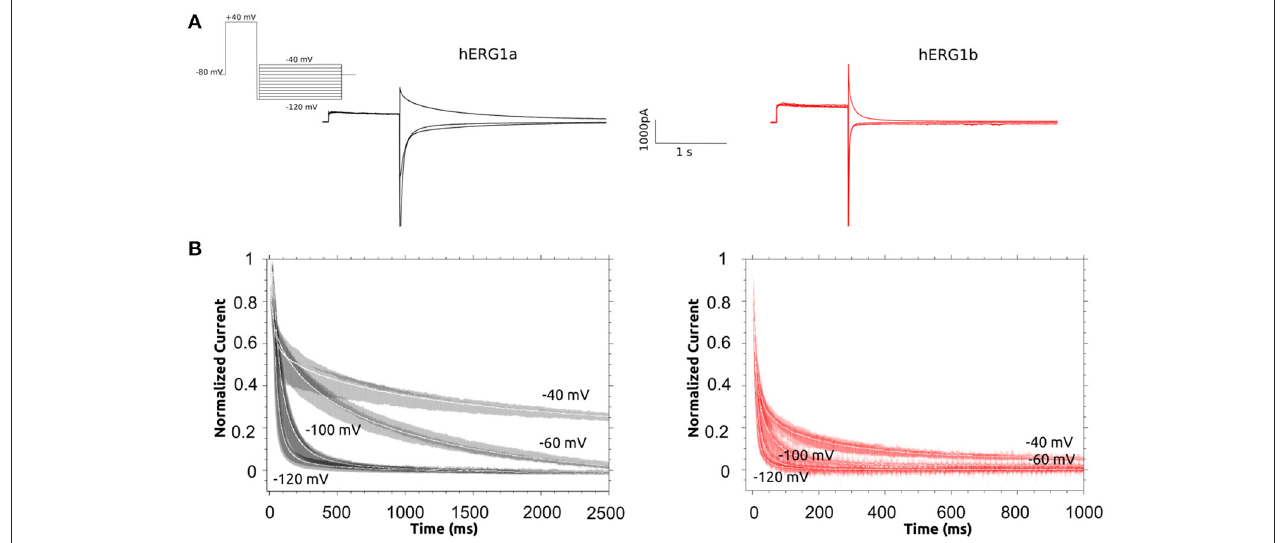
FIGURE 5 | Deactivation Kinetics of hERG1a and hERG1b channels measured in HEK cells. (A) Representative current traces elicited by the voltage protocol shown in the top for both isoforms. (B) Superimposed raw deactivation time courses for voltages − 40, − 60, − 100, and − 120mV for hERG1a ( n = 10) and hERG1b ( n = 10). Average time course is shown with a solid white